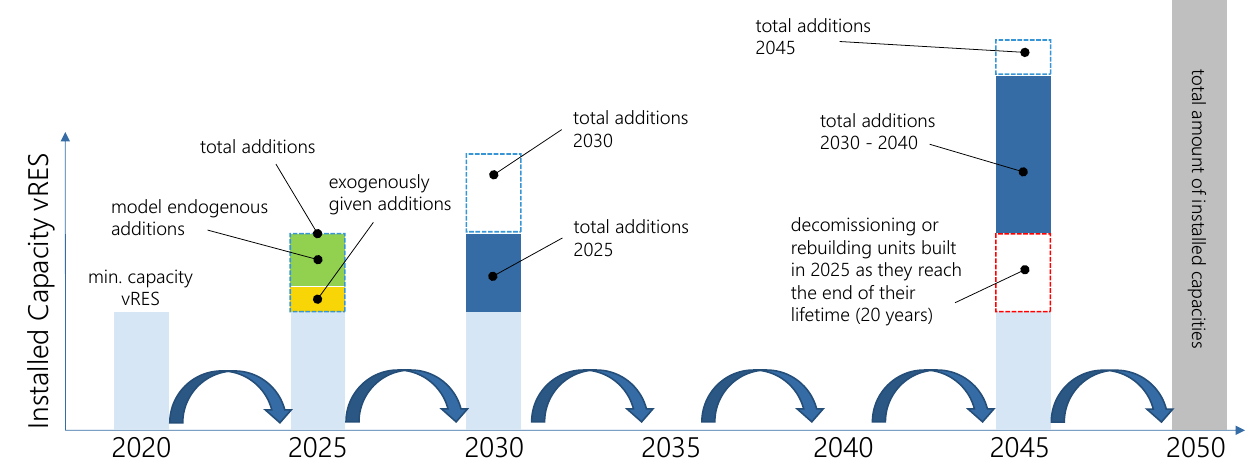
Figure 2. Sequence for vRES additions in ISAaR. Own figure based on [28,30].